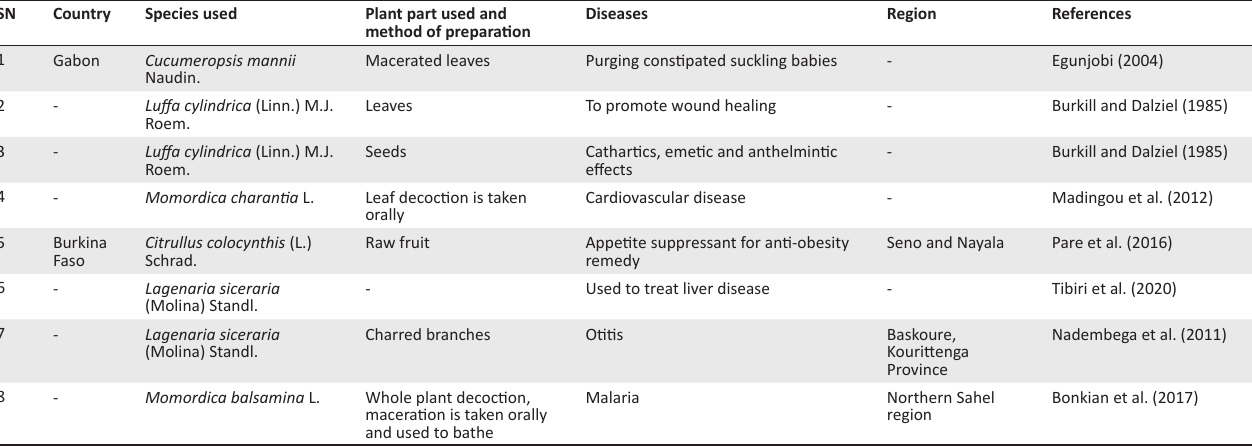
TABLE 7: Cucurbitaceae species used as traditional medicine in Gabon and Burkina Faso. SN Country